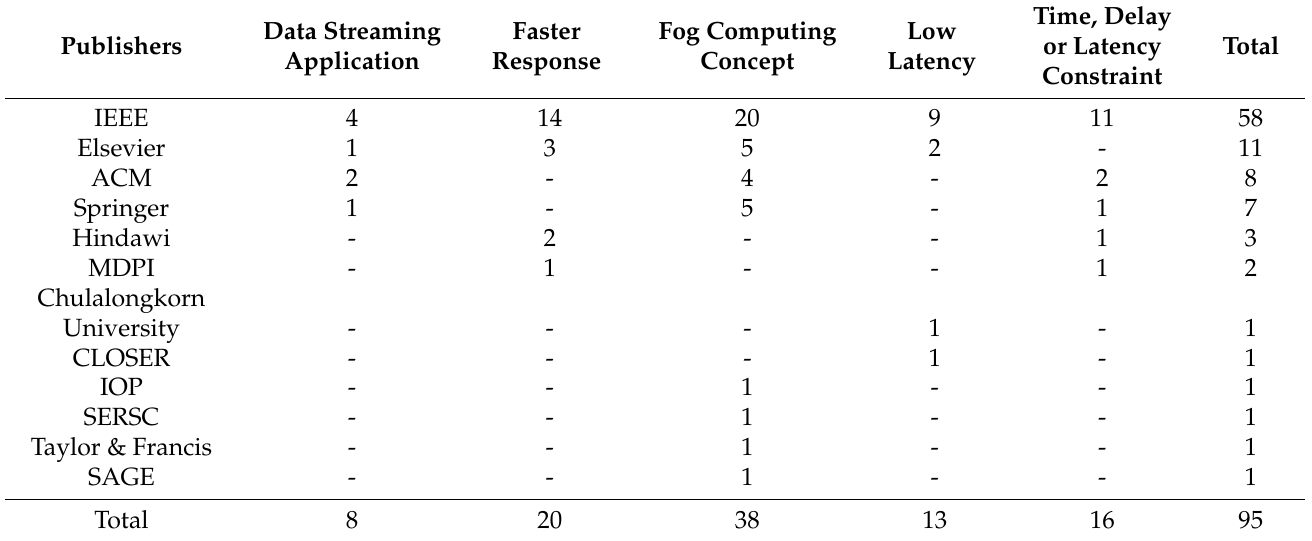
Table 2. Publications separated by publisher and category.